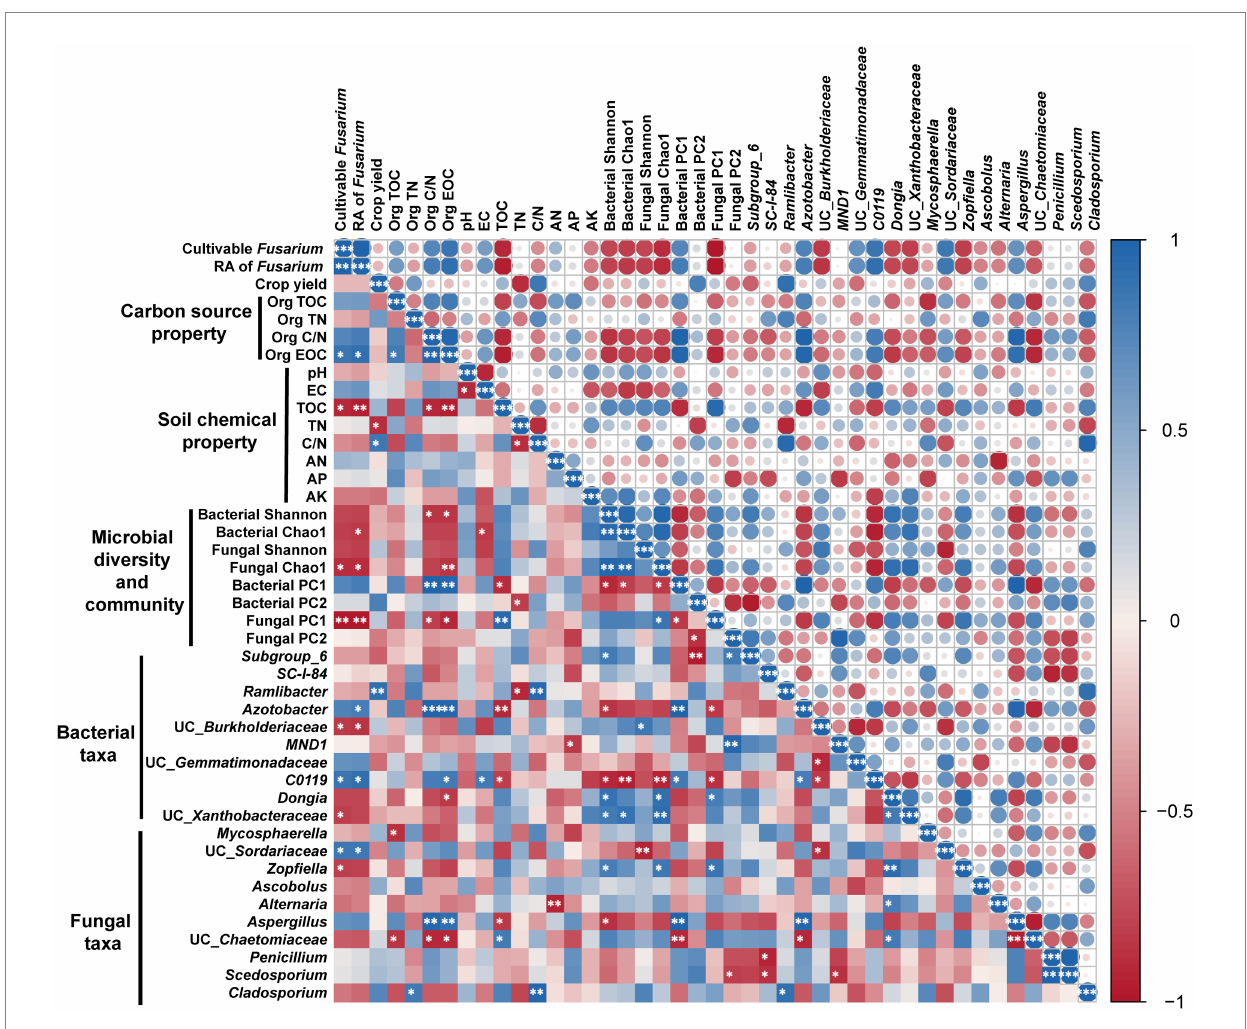
FIGURE 5 Relationships among microbe, crop yield, carbon source property, and soil chemical property after two planting seasons. Circle color and size represents Pearson correlation coefficients ( r ). * p < 0.05; ** p < 0.01; *** p < 0.001. Only the top 10 bacterial and fungal genera are shown. Impact factor abbreviations are defined in Table 1 and Figure